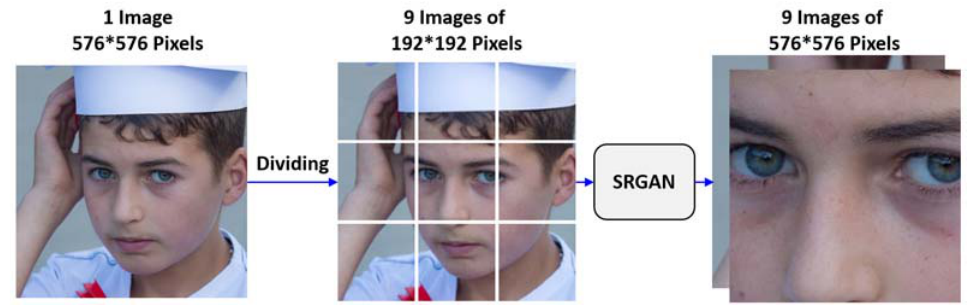
Figure 14. Result of applying super resolution with SR ‐ GAN.